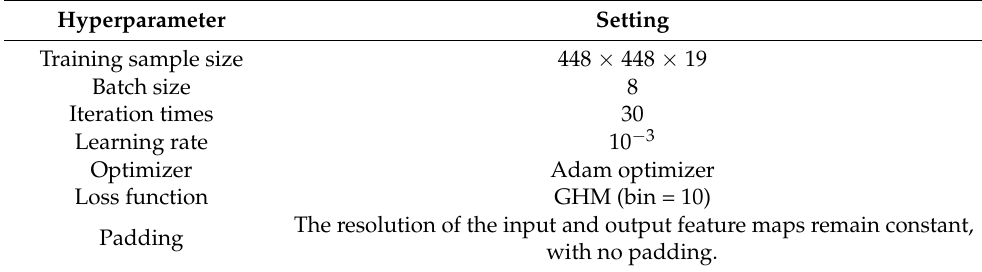
Table 2. Model hyperparameter